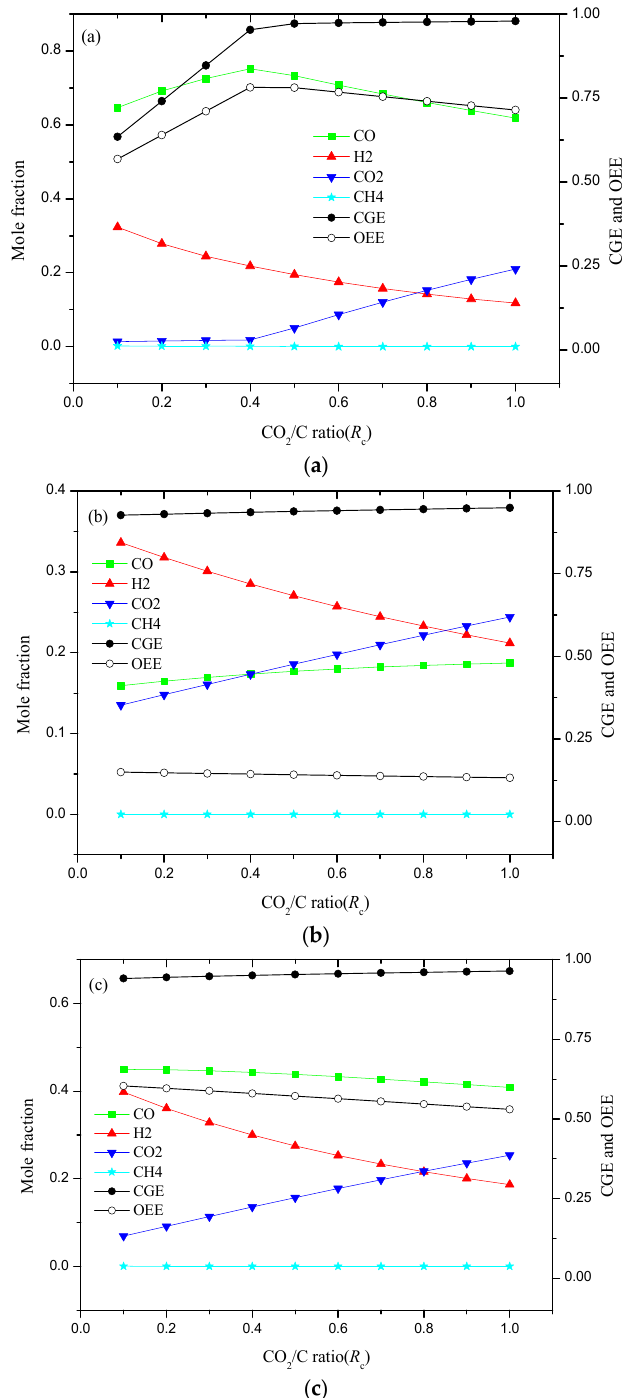
Figure 5. E ff ect of R c on raw syngas composition and system performance ( T = 900 ◦ C and R o = 0.2): Figure 5. Effect of R c on raw syngas composition and system performance ( T = 900 °C and R o = 0.2): ( a ) ( a ) BC; ( b ) MSW; ( c ) R M = BC; ( b ) MSW; ( c ) R M = 0.6.